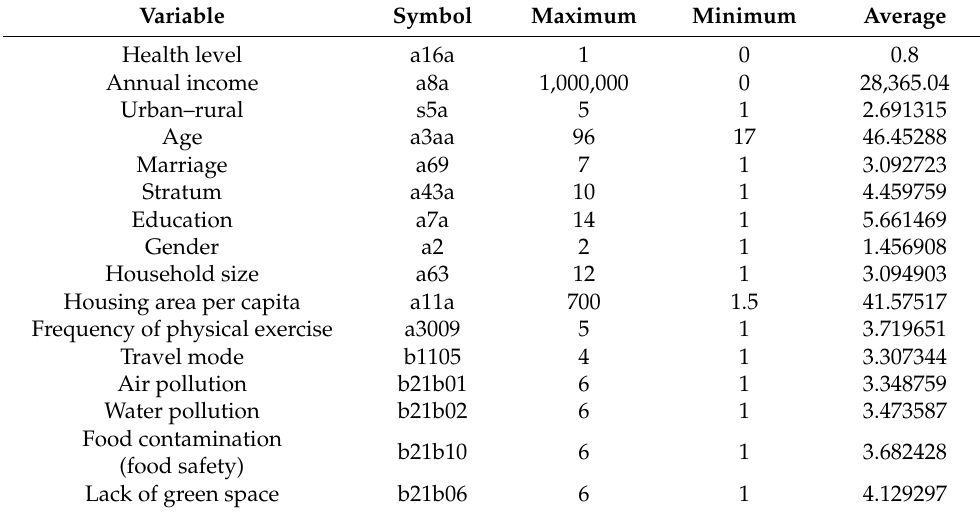
Table 2. Statistical description of